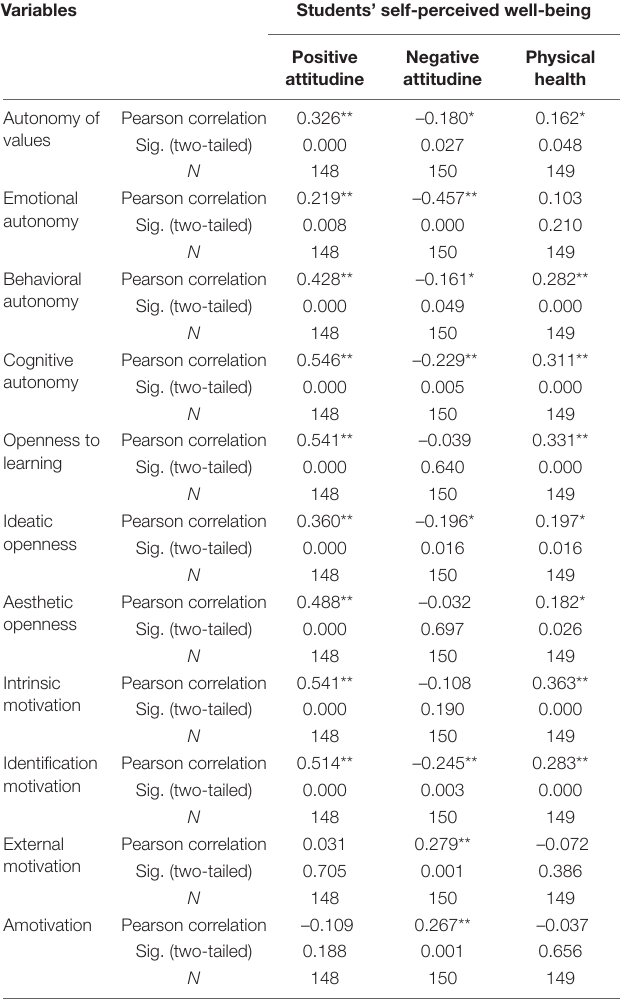
TABLE 2 | Pearson correlation between students’ self-perceived well-being and personal autonomy, openness, and mechanisms for regulating motivation. Variables Students’ self-perceived well-being